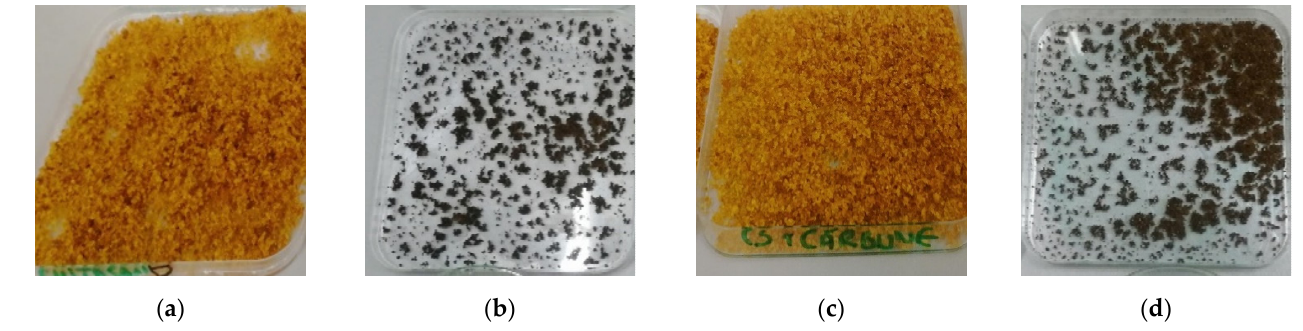
Figure 3. The appearance of CS (wet—( a ), dried—( b )) and CS–BPA (1:1) (wet—( c ), dried—( d )) microbeads.